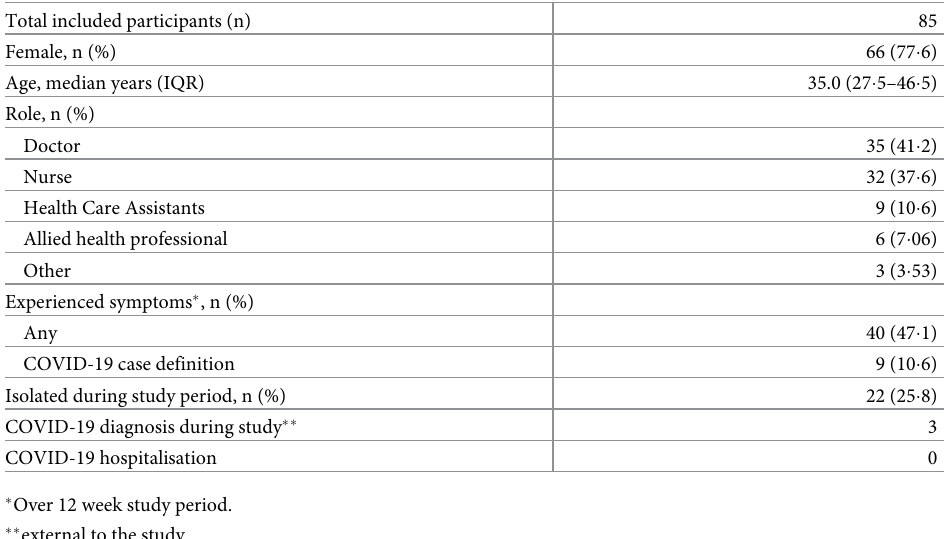
Table 1. Participant